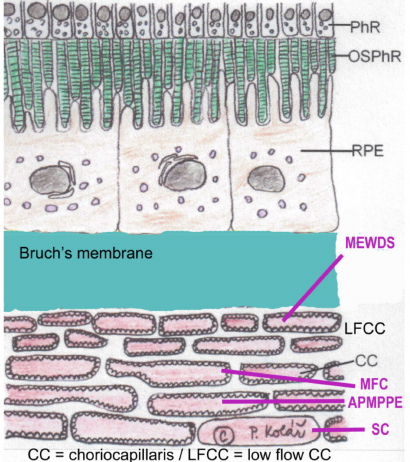
Figure 6. Clinicopathology of PICCPs according to size of non-perfused vessel. Schematic represen- tation of the choriocapillaris with inner low-flow choriocapillaris (LFCC), the occlusion of which is at the origin of MEWDS. Occlusion of larger choriocapillaris vessels (CC) are at the origin of more severe conditions such as APMPPE, MFC or SC. (Reprinted by permission and modified from Petr Kolar, DOI:10.5772/53762) PhR = photoreceptors; OSPhR = outer segments of photoreceptors; RPE = retinal pigment